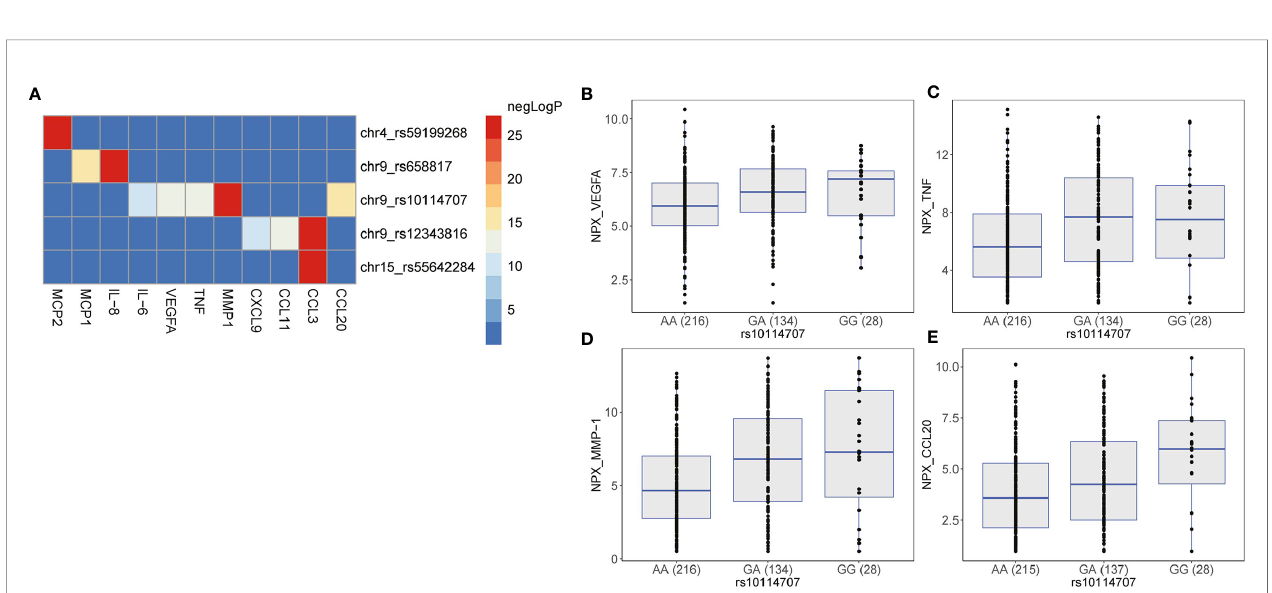
FIGURE 3 | (A) Regional association plot at rs10114707 (purple diamond) that in fl uences MMP-1, which is in close proximity to GADD45G gene at chromosome 9. Each dot represents a SNP, which shows a meta-analysis P value < 0.05 and the same direction in the 500FG and Lifelines Deep cohort. The linkage disequilibrium (LD) of neighboring SNPs with the top SNP is color-coded. The y-axis represents negative logarithm of P values of SNPs. The x-axis shows chromosomal positions on Genome build GRCh37 (hg19). (B) Genotype-strati fi ed gene expression levels of GADD45G at rs10114707 locus. Individuals carrying the minor allele G at this locus showed a decrease in GADD45G expression. We presented the regularized-logarithm (rlog; transformed data on the log2 scale) of the counts of GADD45G gene from the two-genotype groups (GA+GG versus AA).